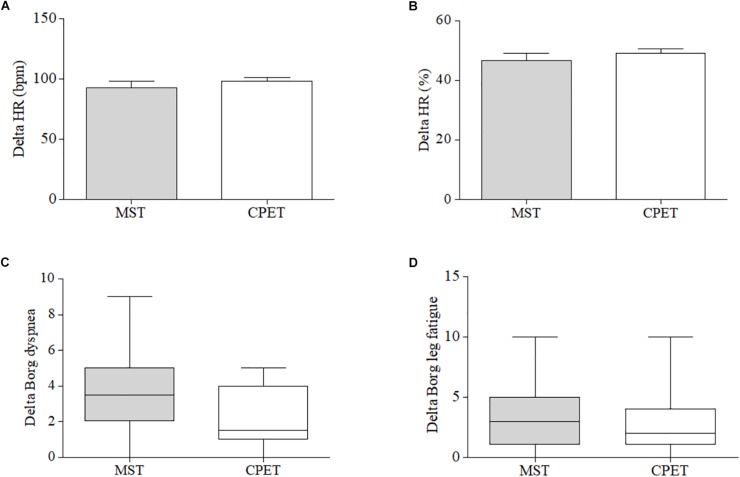
Comparison of the difference (delta) between peak and resting values (bpm) of (A) maximum heart rate (HRmax), (B) percentage of HRmax and subjective perception of (C) dyspnea and (D) leg fatigue.